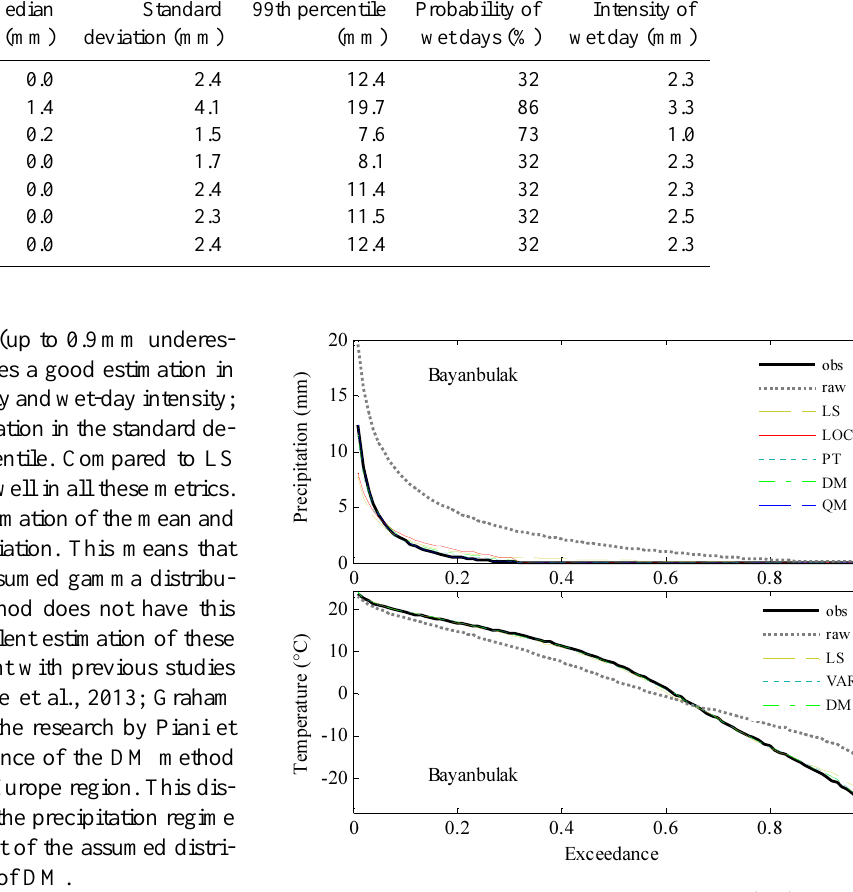
Figure 4. Exceedance probabilities of the observed (obs) , raw, and bias-corrected precipitation (top) and temperature (bottom) at the Bayanbulak